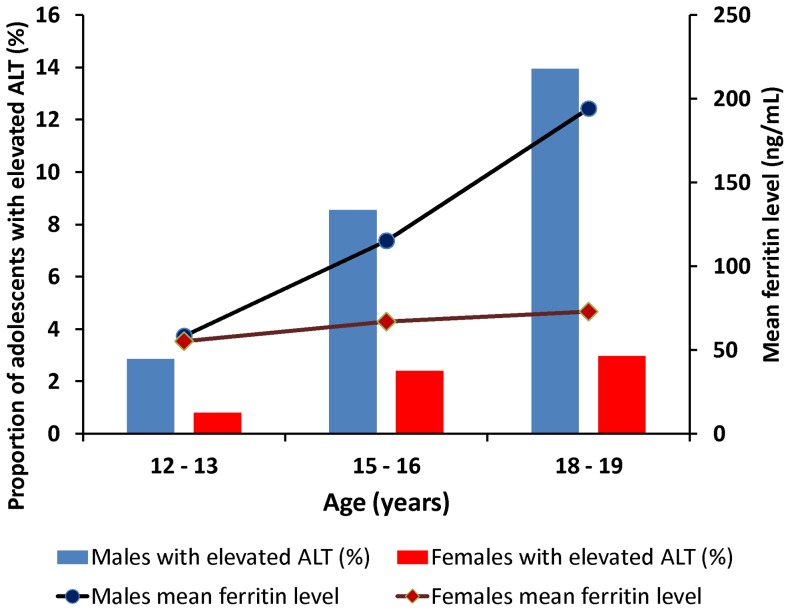
The mean ferritin levels and the proportion of adolescents with elevated ALT levels in the participants divided into three age groups.